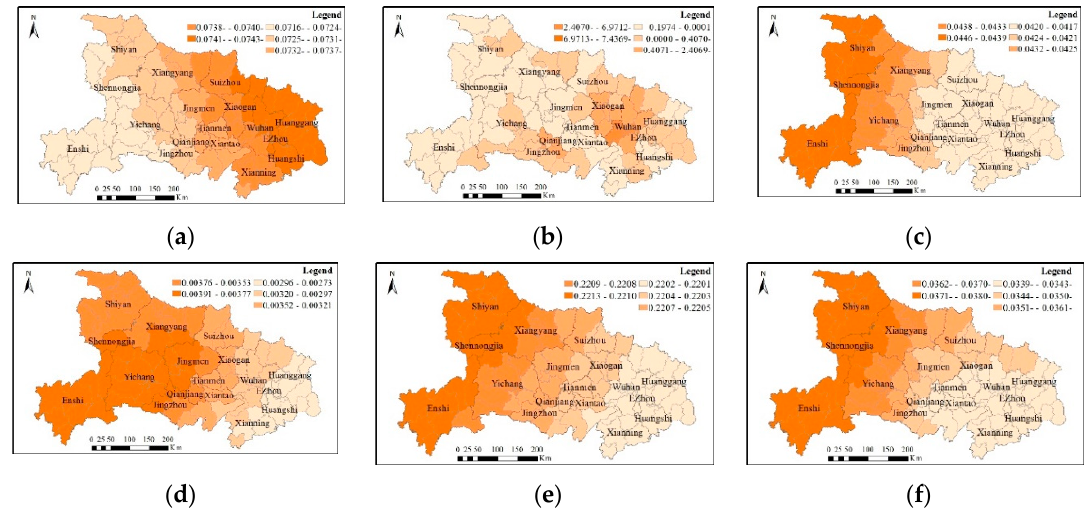
Figure 8. The scale difference of different factors: ( a ) Migration form Wuhan; ( b ) Migration from other area; ( c ) GDP; ( d ) Integrated distance; (e ) Population density; ( f ) Impervious areas.